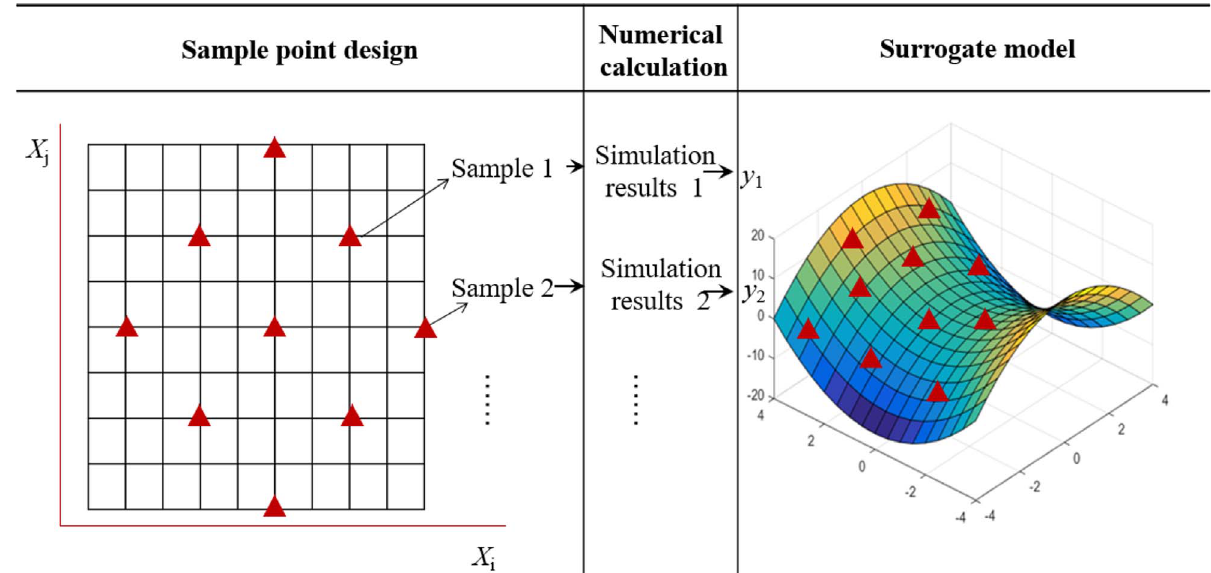
Figure 1. Typical surrogate modeling